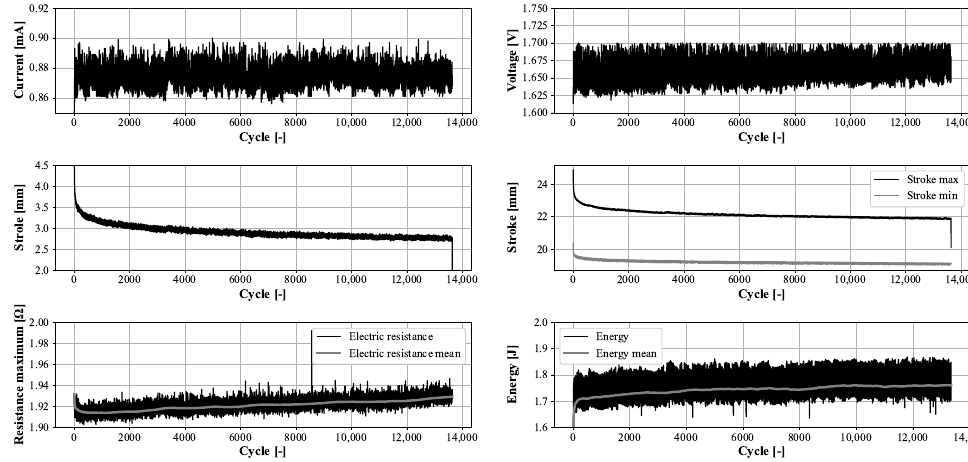
Figure 10. Input parameters for the plausibility analysis of the model. As expected the resulting stroke and the enpositions decrease with an increasing num- ber of cycles. The current is controlled constant at approximately 880 mA. As mentioned before, the resistance increases over time. As a result the voltage increases as well. Since the energy is the product of voltage, current and the timestep it is increasing as well. Several assumptions are derived from the plots in Figure 10 going into the plausibility analysis: